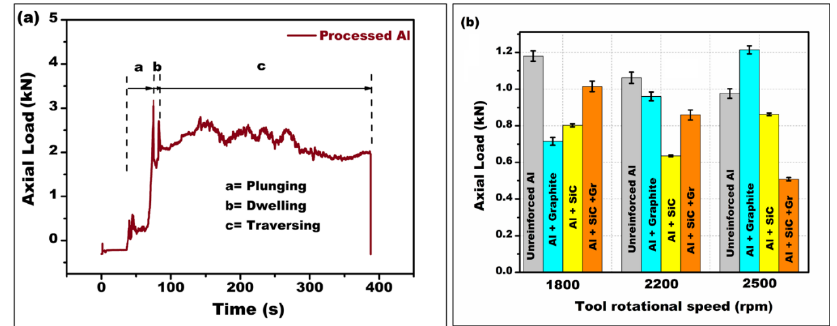
Figure 3 . Axial load variation: ( a ) Axial load vs. time curve for non-reinforced processed Al6061 at 2200 rpm; ( b ) axial load vs. tool rotational speed for different reinforcements. Graphite is abbreviated as Gr.